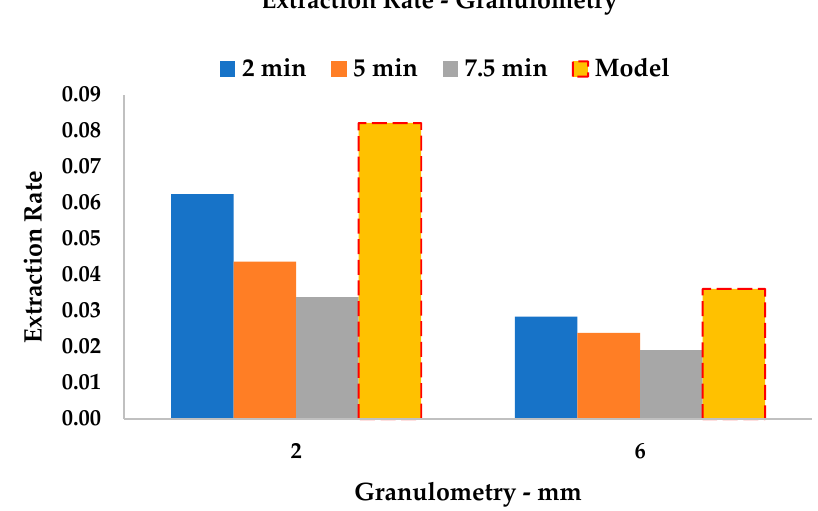
Figure 9. Extraction-rate variation with granulometry. B t of 2, 5 and 7.5 min compared to overall B 0 .